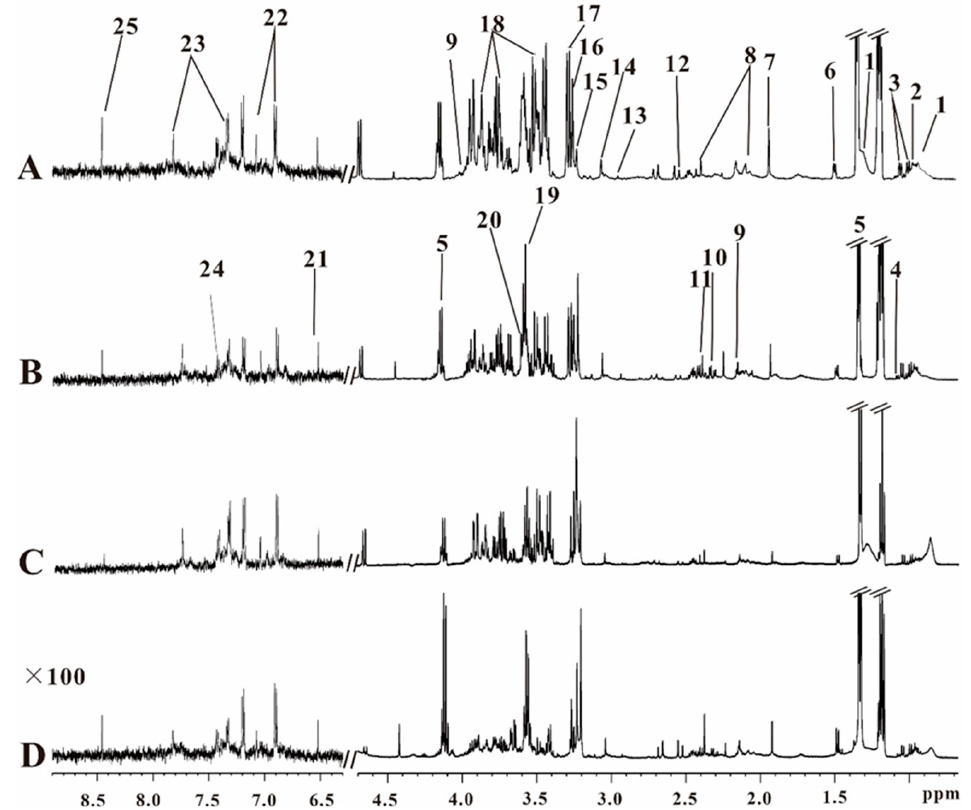
Figure 1. Representative serum 1 H-NMR spectra of ( A ) ApoE − / − mice, ( B ) ApoE − / − ;SAP − / − mice, ( C ) SAP − / − mice, ( D ) C57 mice. (The spectral peaks in the range of δ 6.3–8.9 are amplified 100 times.) 1. VLDL + LDL. 2. leucine/isoleucine (Leu). 3. valine (Val). 4. α -ketoglutarate. 5. lactate (Lac). 6. alanine. 7. Acetate (Ace). 8. glutamine. 9. acetoacetate. 10. pyruvate(Pyr). 11. succinate(Suc). 12. citrate. 13. dimethylamine. 14. Creatine (Cr). 15. Choline (Cho). 16. TMAO. 17. Taurine (Tau). 18. α , β -glucose ( α , β -Glc). 19. glycine(Gly). 20. glyceride. 21. fumarate. 22. Tyrosine (Try). 23. Histidine (His). 24. Phenylalanine (Phe). 25.